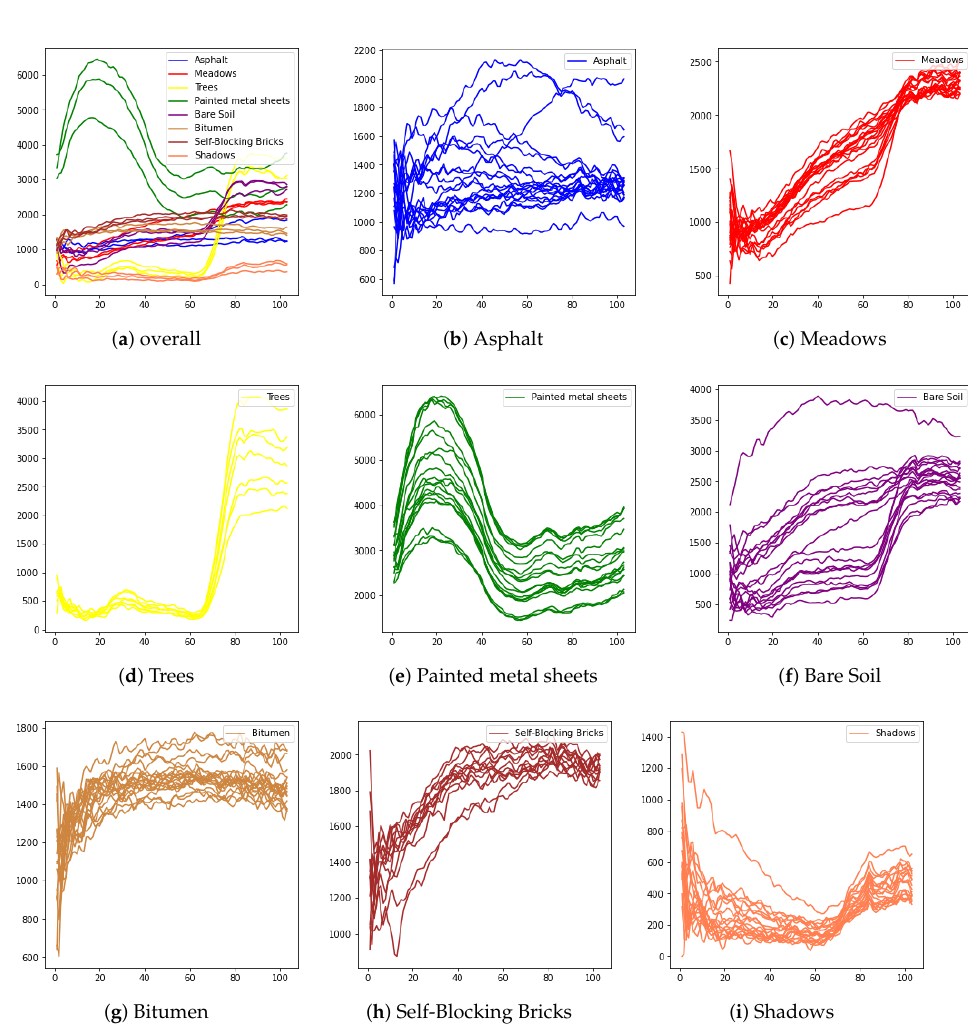
Figure 10. The spectral information of the University of Pavia